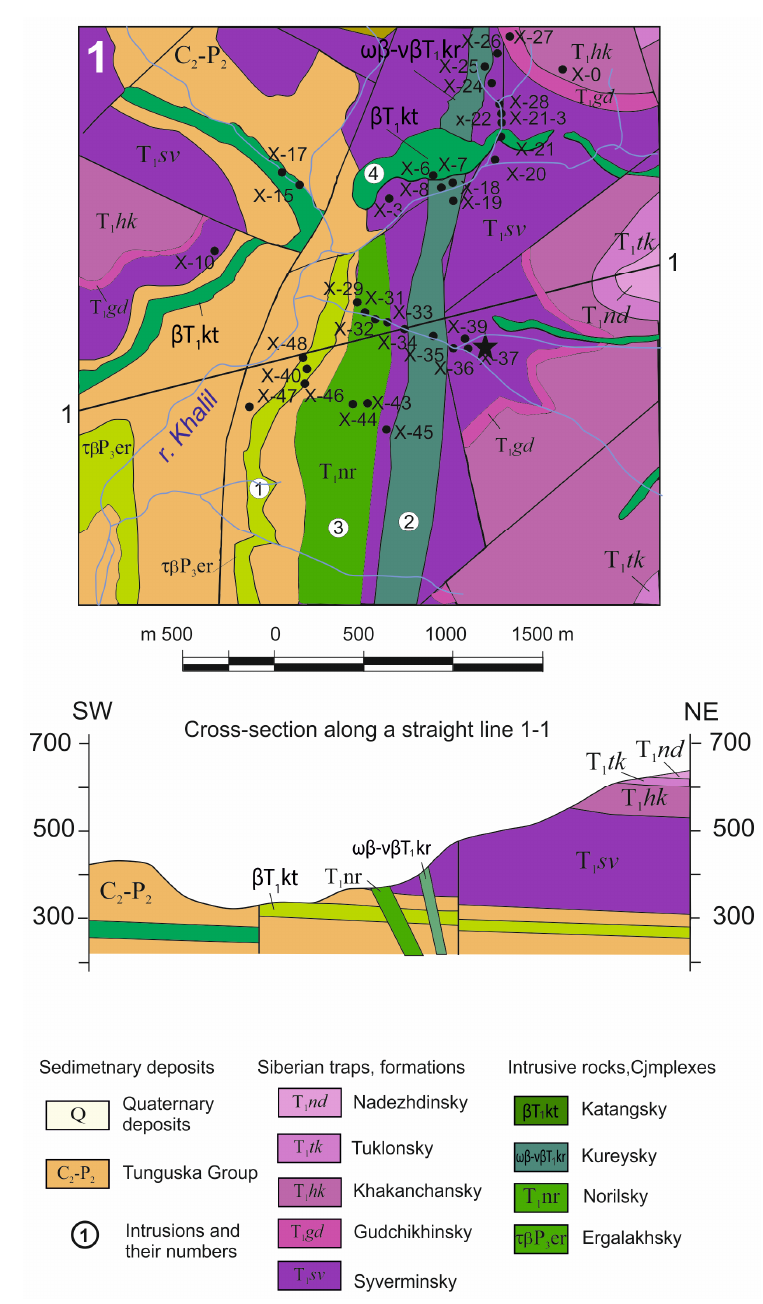
Figure 4. Geological map of the Khalil site (after Ltd. Norilskgeology data with the authors’ corrections). Line 1-1 demonstrates the position of the cross-section; X-8, X-18: positions of samples; studied intrusions, complexes 1: Ergalakhsky; 2: Kureysky (Khalil intrusion); 3: Norilsk; 4: Katangsky; black star: Paleo volcano.